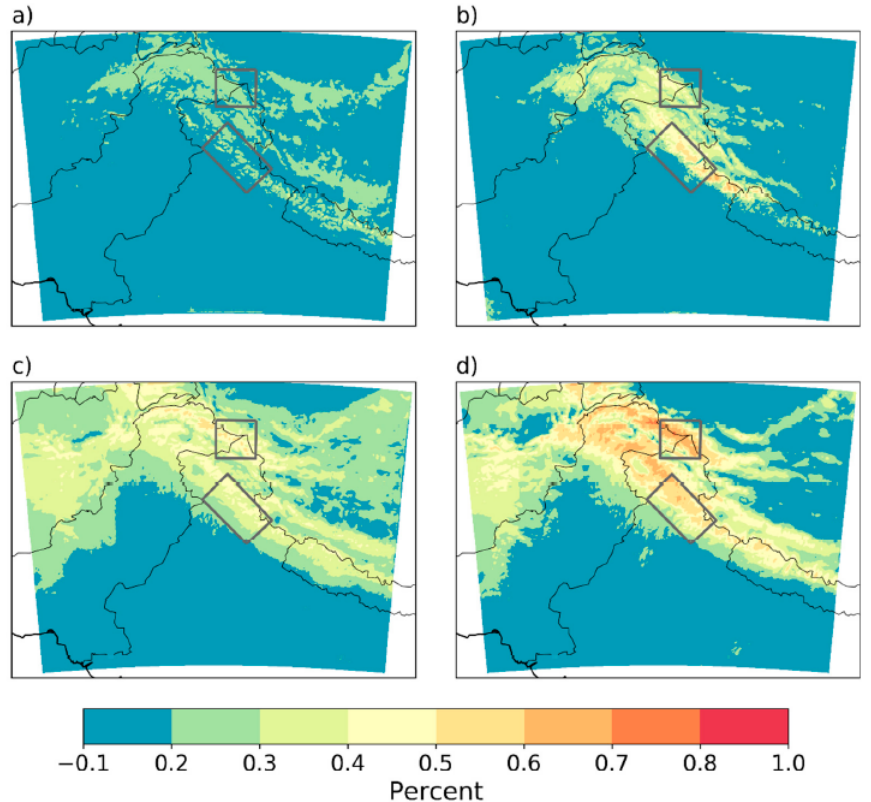
Figure 7. Pearson correlation coefficients between precipitation and ( a ) warm-season (June– September) IWV, ( b ) warm-season IVT, ( c ) cool-season (December–March) IWV, and ( d ) cool-season IVT. All correlations are calculated based on hourly data. Grey boxes indicate Karakoram (top) and western Himalaya (center)